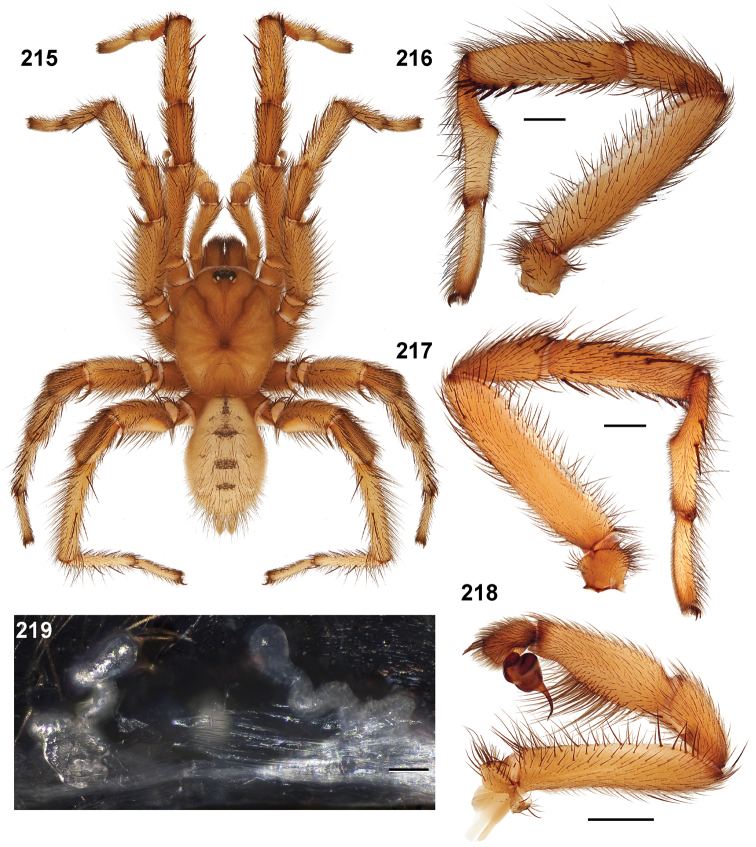
Aptostichus serrano sp. n. 215–218 male holotype (AP395); scale bars = 1.0mm. 215 habitus [805962] 216 retrolateral aspect, leg I [805954] 217 prolateral aspect, leg I [805960] 218 retrolateral aspect, pedipalp [805958] 219 cleared spermathecae (AP712) [806611]; scale bar = 0.1mm.